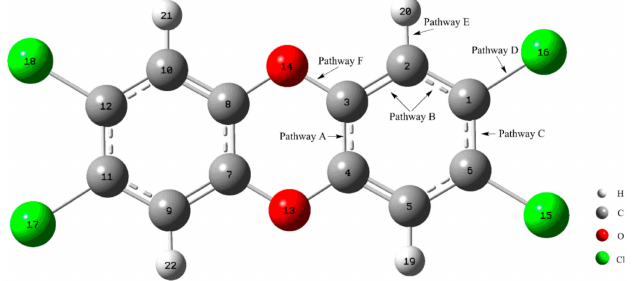
Figure 1. The C-X (X=C, Cl, H, O) bonds of TCDD attacked by CH radical in the studied